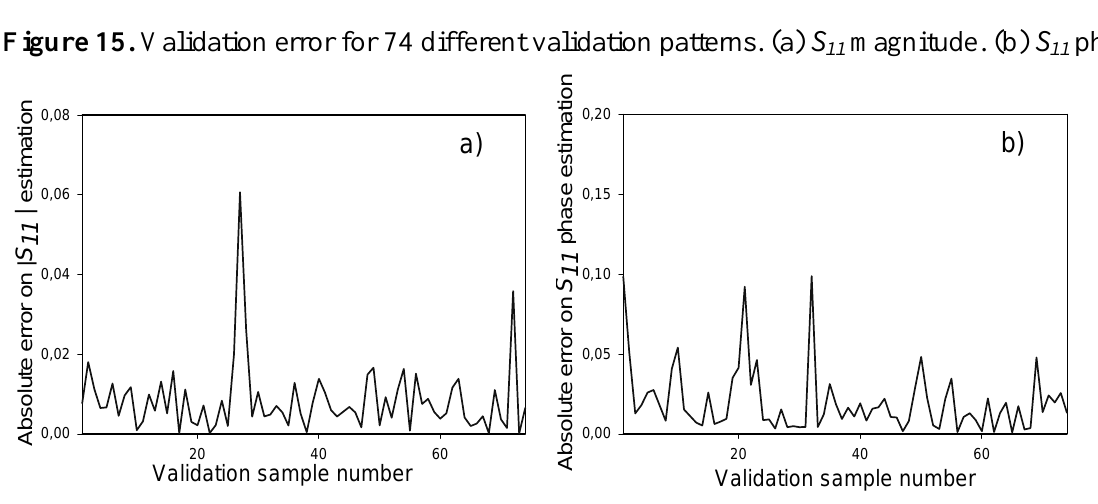
Figure 15. Validation error for 74 different validation patterns. (a) S